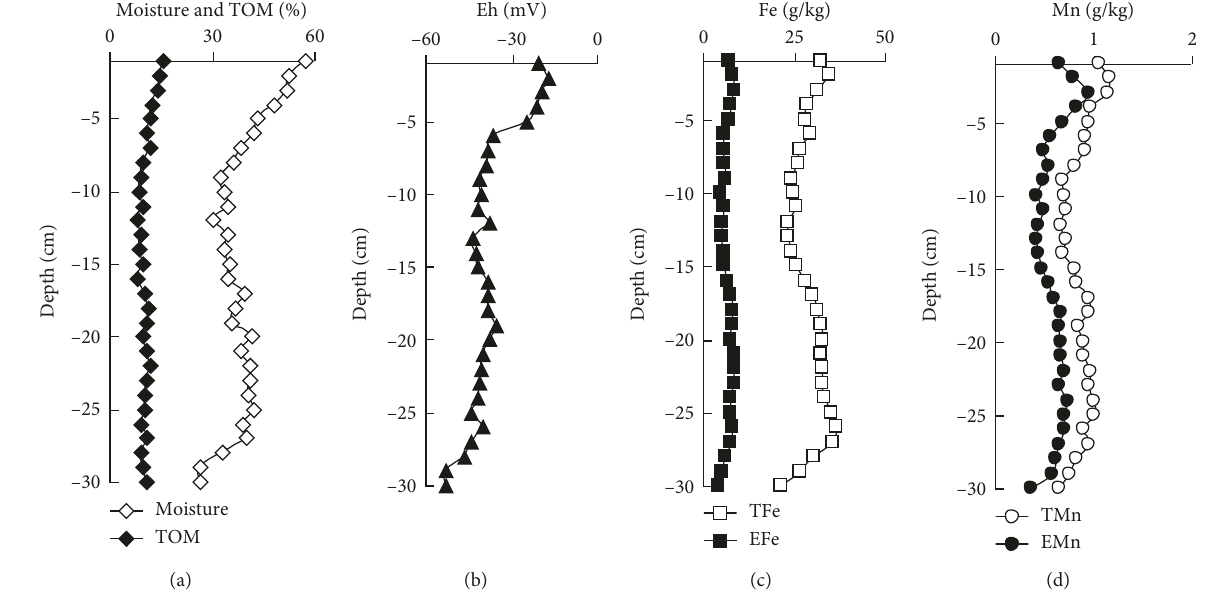
Figure 2: Profiles of moisture and TOM (a), Eh (b), Fe (c), and Mn (d) in